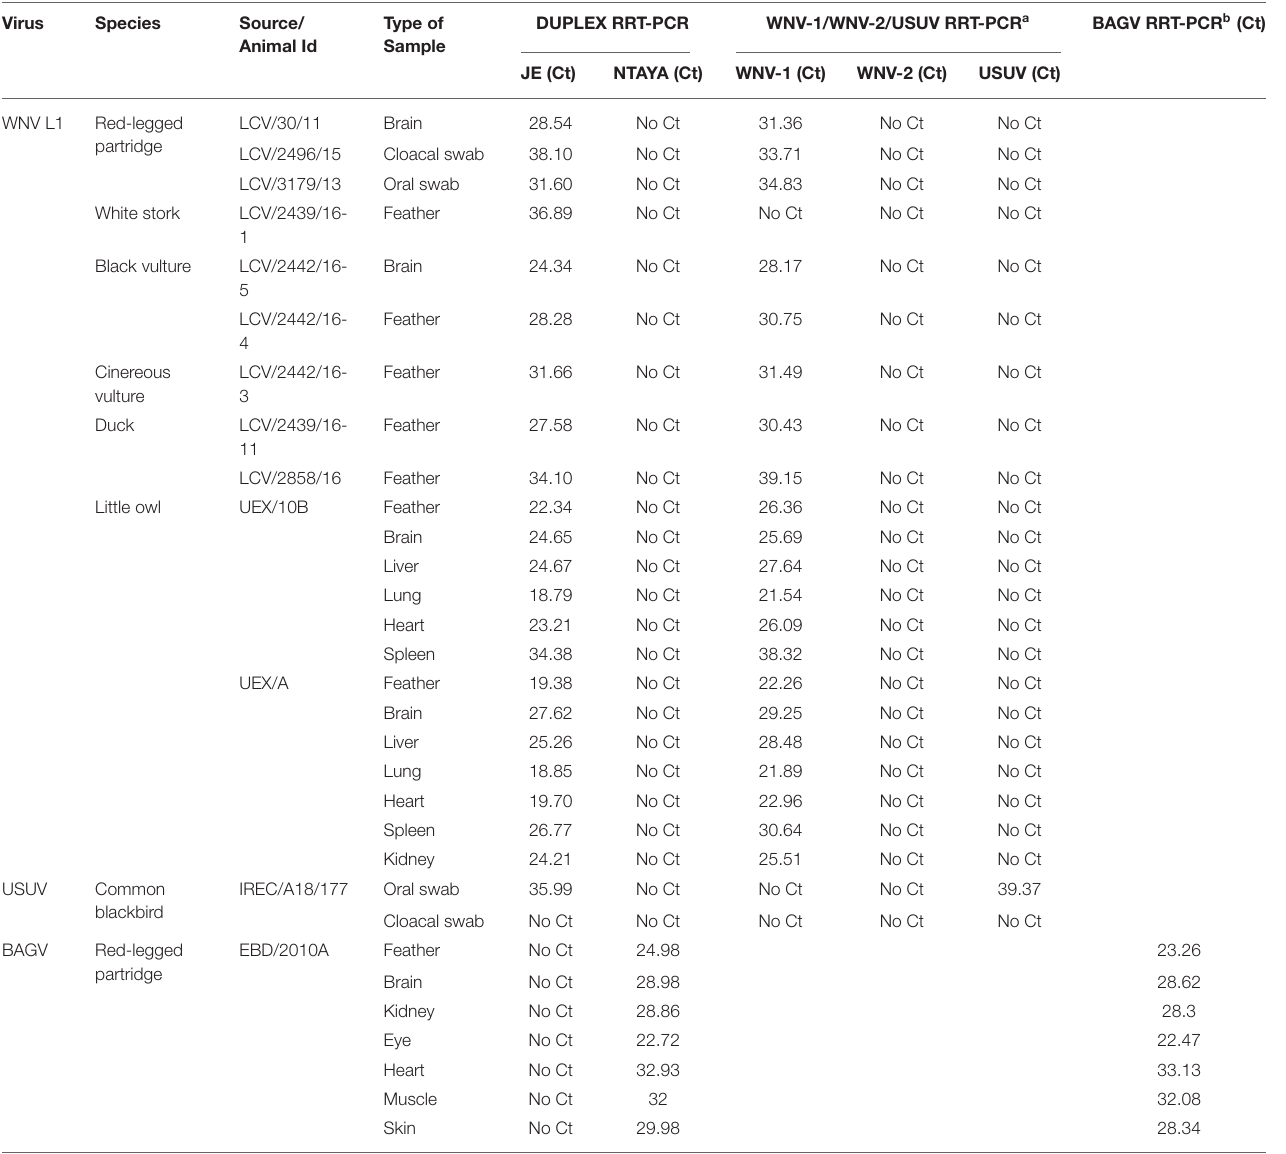
TABLE 2B | Clinical samples used in this study and results obtained by the dRRT-PCR and the RT-PCR methods used as reference; field samples from wild birds collected in Spain. Virus Species